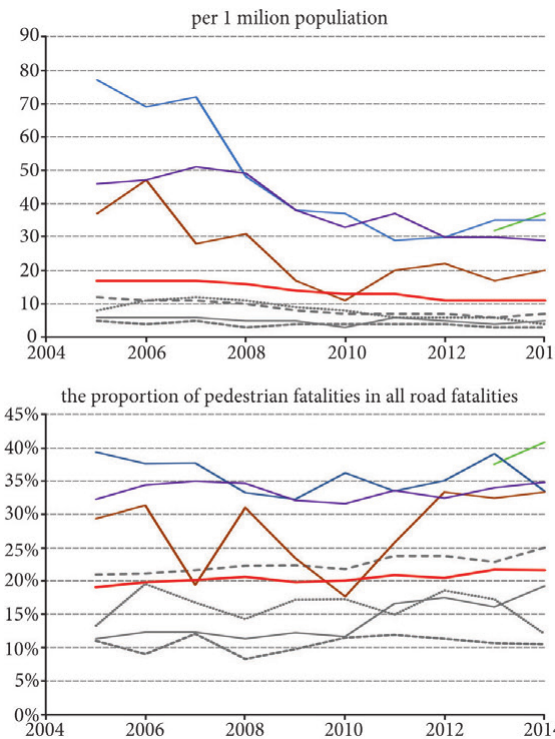
Fig. 2. Pedestrian fatalities according to the data of 2016 from the European Road Safety Observatory (ERSO 2016b)